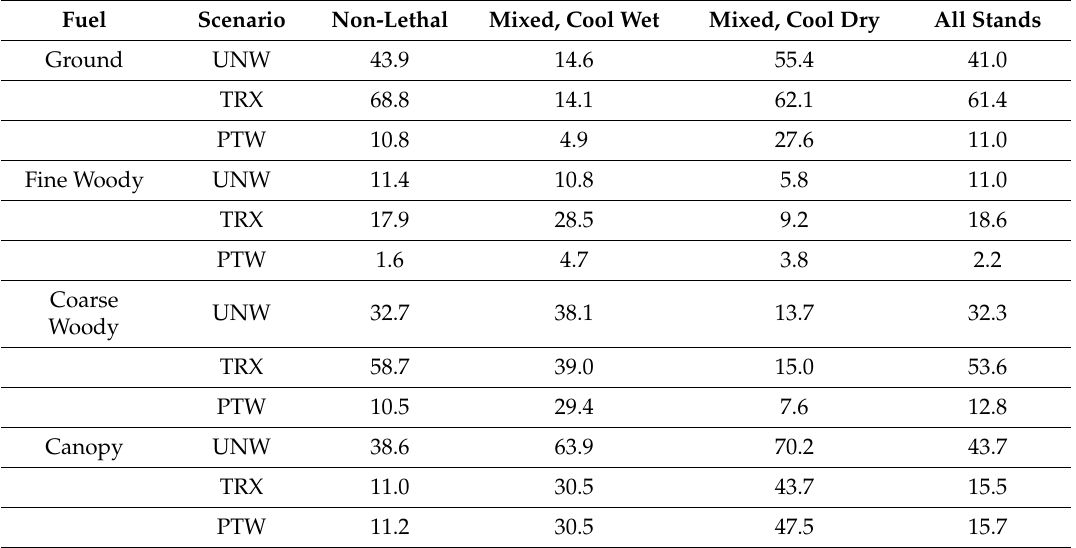
Table 3. Summary of fuel types, treatments, and estimated average fuel loadings in megagrams per hectare. Ground fuels include du ff and litter, fine woody includes 1–100 h woody fuel, coarse woody includes 1000 h and larger sound and rotten woody fuel, and canopy includes over-, mid-, and lower-canopy